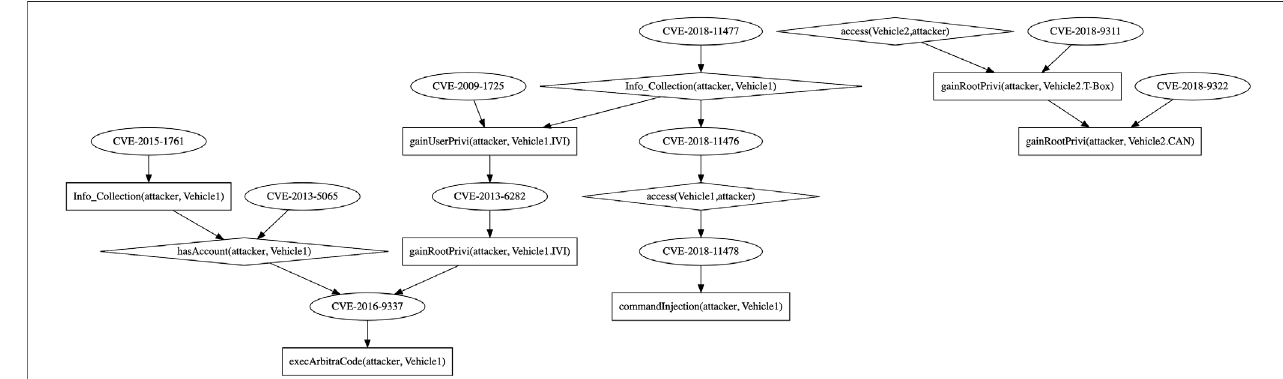
FIGURE 5 | Attack graph at time T 0 .